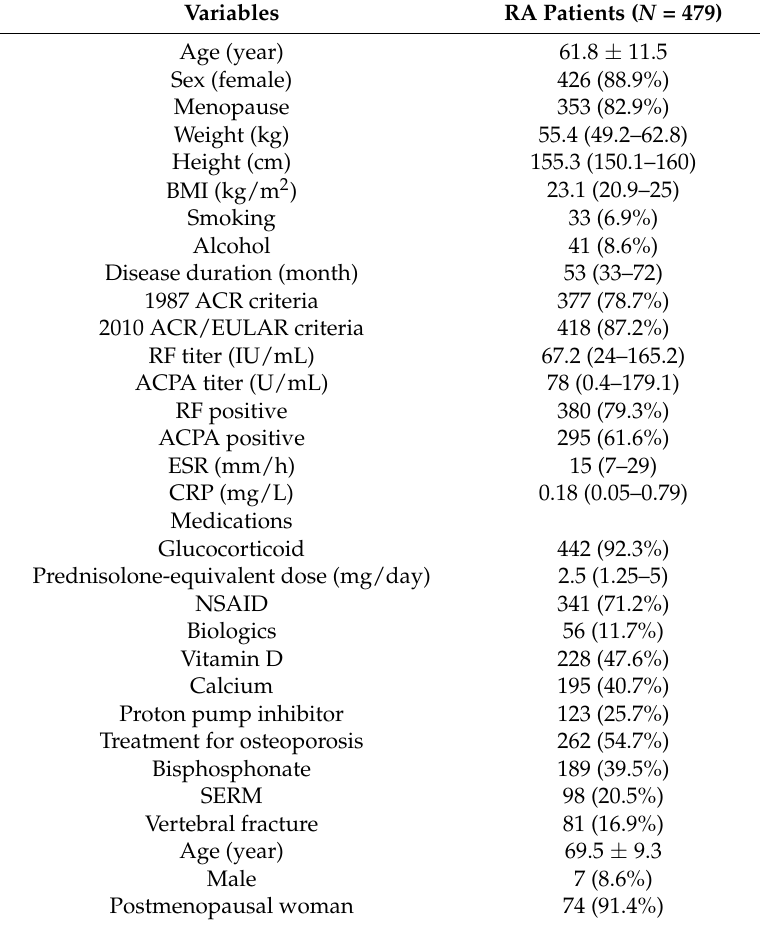
Table 1. Baseline characteristics of the study